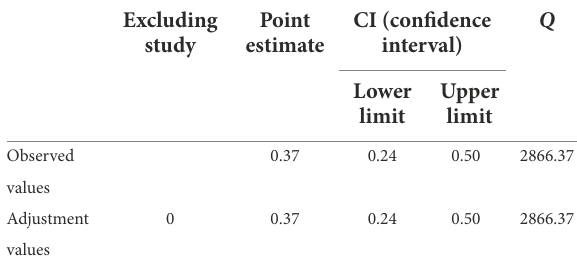
TABLE 4 The results of Duval and Tweedie’s trim and fill